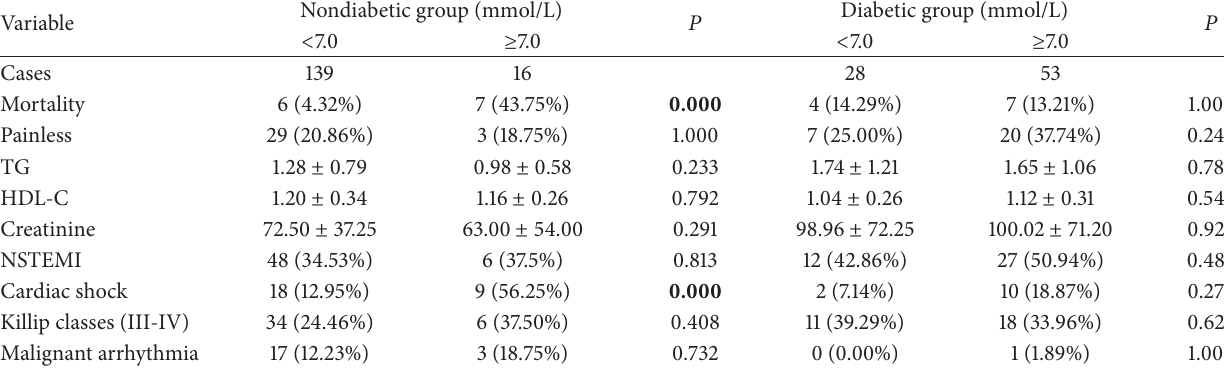
Table 3: Comparison of different fasting glucose levels between nondiabetic group and diabetic group.